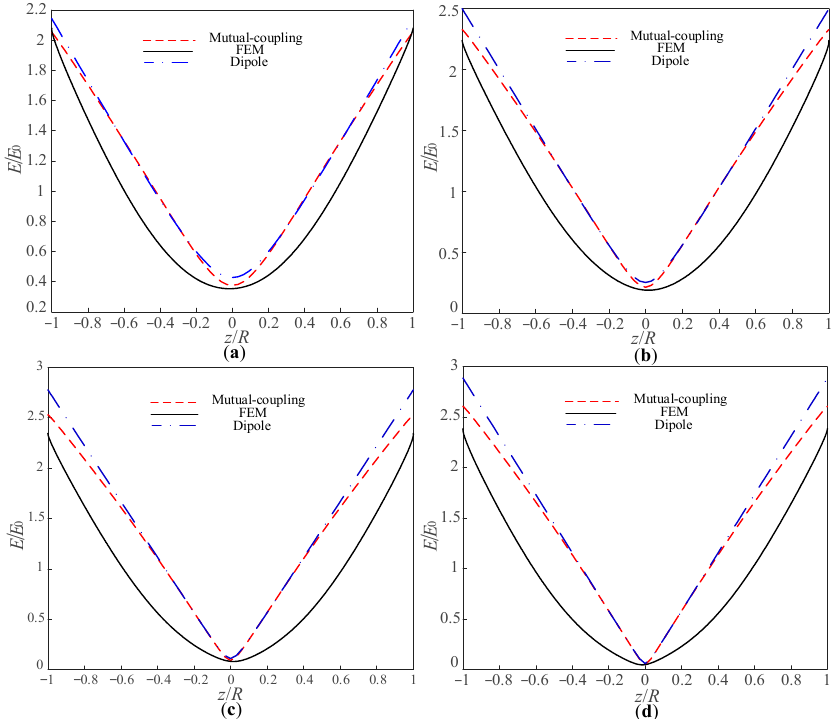
Figure 10. Calculation results of the electric field distribution on particle 1 when D / R = 0.6: ( a ) Calculation results when ε i / ε e = 5; ( b ) Calculation results when ε i / ε e = 10; ( c ) Calculation results when ε i / ε e = 25; ( d ) Calculation results when ε i / ε e = 50.